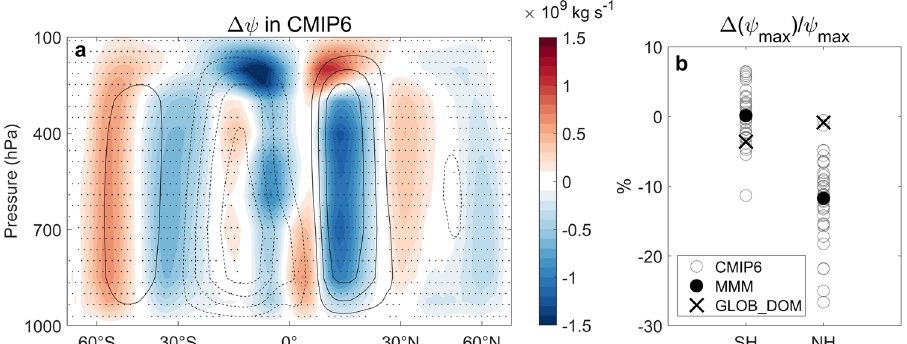
Fig. 1 Hadley circulation responses to global CO 2 forcing in CMIP6. a Multi-model mean changes of the atmospheric annual-mean meridional streamfunction (shading; interval = 10 8 kg s − 1 ) averaged for years 11 – 60 after an abrupt global quadrupling of CO 2 concentrations from the corresponding pre-industrial control climatology averaged over the last 100 years (contours; interval = 2 × 10 10 kg s − 1 ) for 40 CMIP6 models. Positive values (red shading and solid contours) correspond to a clockwise circulation and negative values (blue shading and dashed contours) to a counterclockwise circulation. Stippling indicates areas where at least two third of the models agree on the sign of the change. b Percentage changes of the southern and northern Hadley cell intensity ( Δ ψ max = ψ max in %) averaged between 10°-20° latitude in each hemisphere. Each CMIP6 model response is shown with open circles, with the multi-model mean in black closed circles, and the GLOB_DOM experiment response indicated by black crosses.